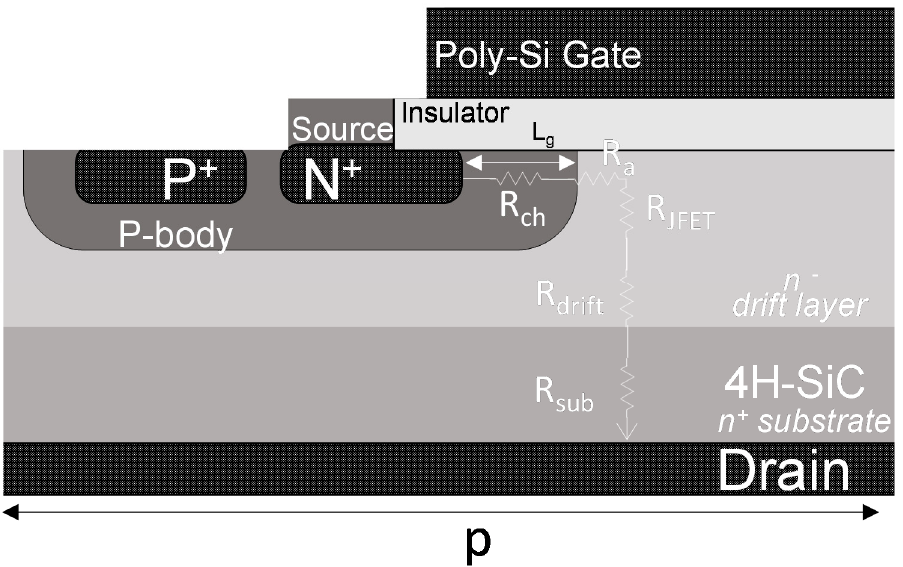
Figure 2. Cross section of a planar 4H-SiC power MOSFET. The vertical path of the current from source to drain electrode, as well as the resistive contributions, are also indicated.